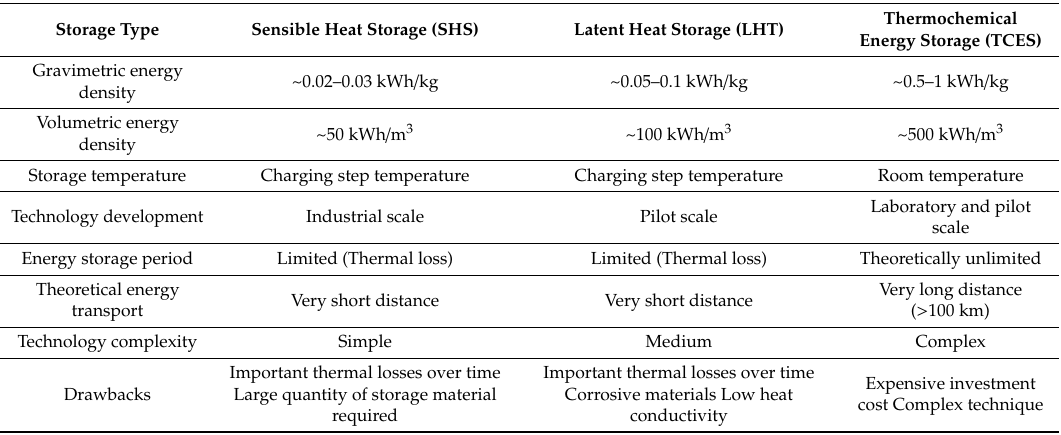
Table 1. Comparison of the main options for thermal energy storage using concentrated solar power (CSP), adapted with permission from [6,7], Elsevier, 2020.